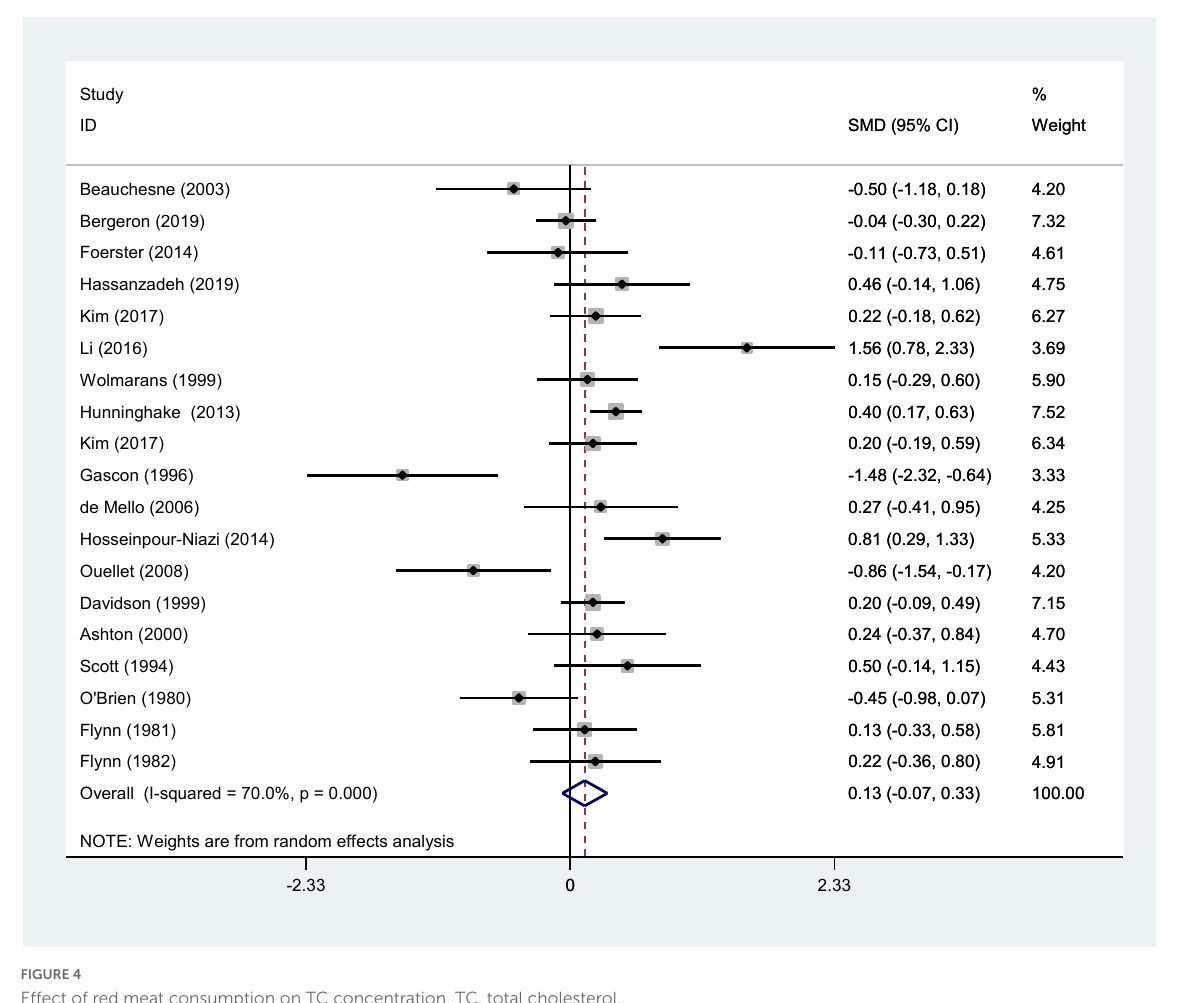
Most of the studies included both men and women ( n = 15), except for 4 studies that included only men (28, 32–34) and 1 study only for women (37). The mean age of all participants was 22 to 59. The control group in 13 articles included white meat and in 7 articles it was legume or dairy products. The intervention duration was < 10 wk in 16 studies and ≥ 10 wk in 4